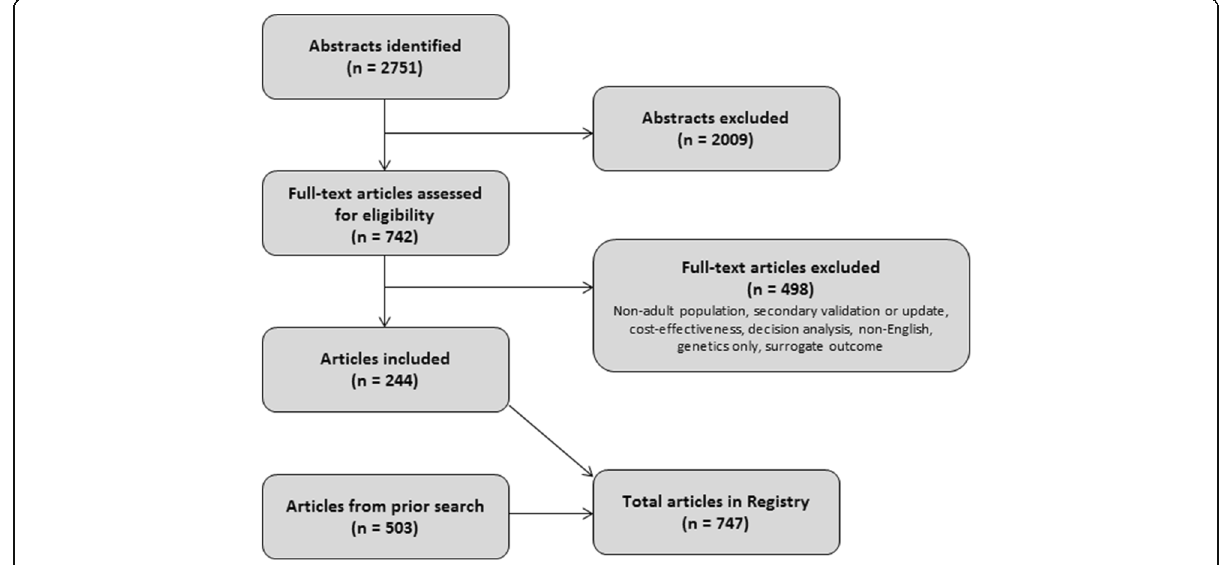
Fig. 1 PubMed was searched for relevant articles from 1990 to March